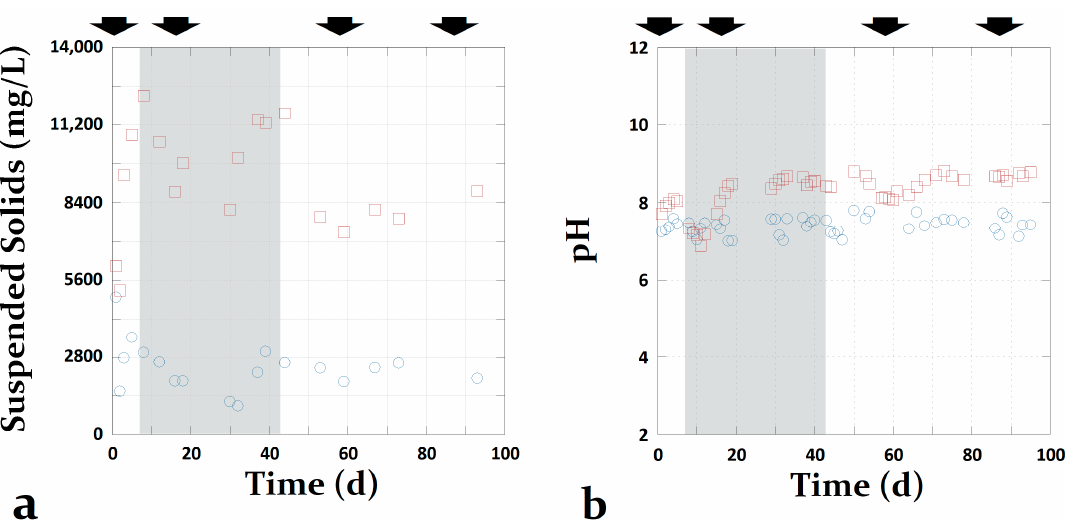
Figure 2. Temporal variation of mixed liquor characteristics. Plots of ( a ) MLVSS, and MLFSS; and ( b ) pH values of the feed, and mixed liquor during MBR acclimatization; the arrows indicate sample collection time points for metagenomic analysis; the shaded area indicates the time period when both CSW and TOPW were fed to the MBR, CSW, and TOPW were solely fed before and after this period, respectively.